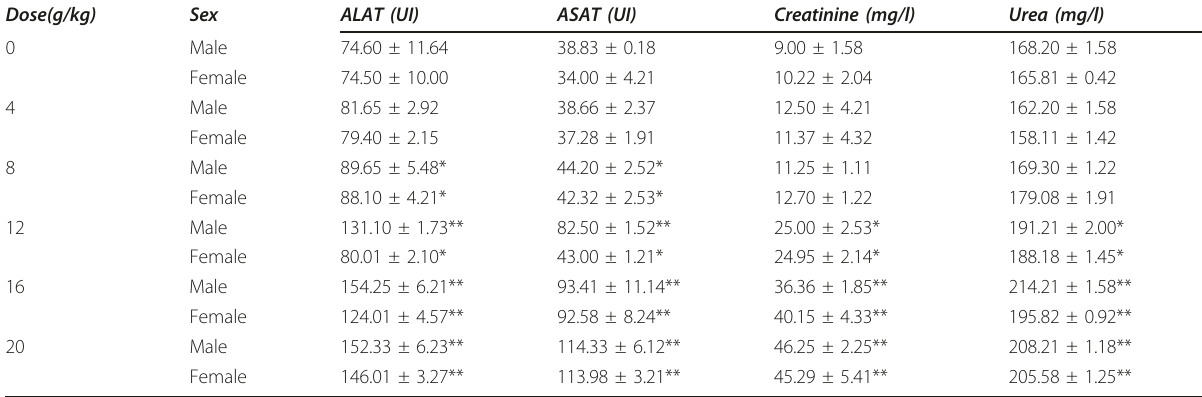
Table 4 Effect of the methanolic extract of Piptadeniastrum africana on different sera biochemical parameters of male and female rats